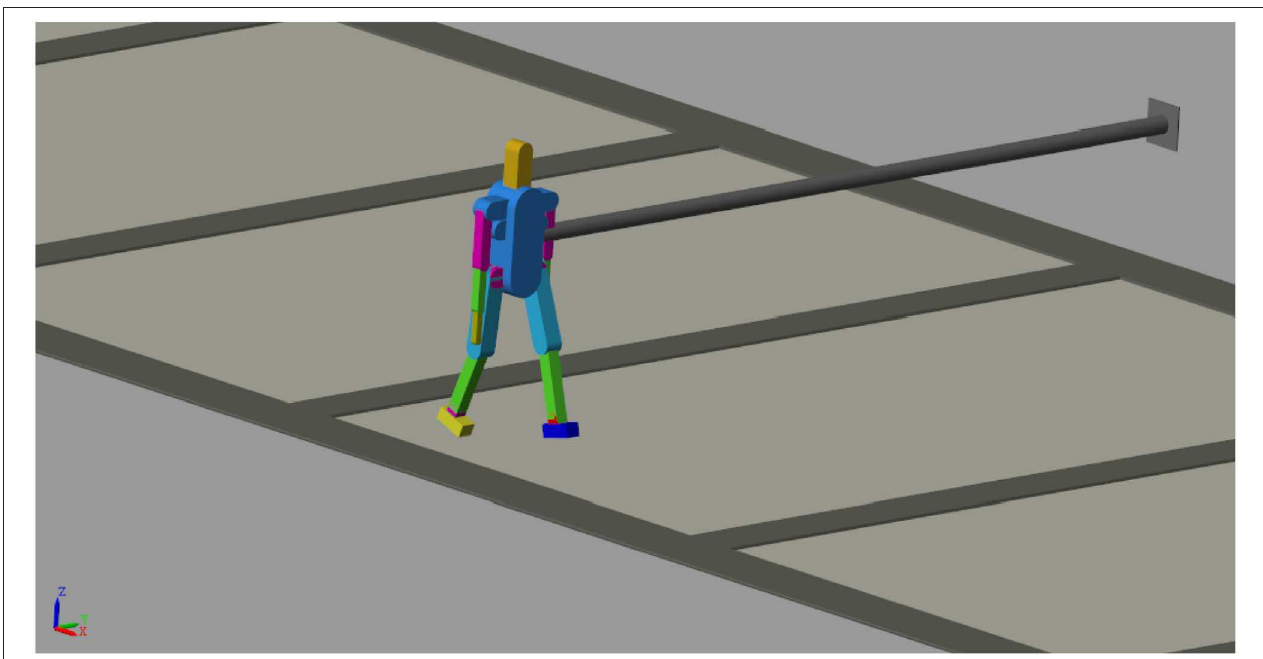
FIGURE 1 | Biped robot virtual